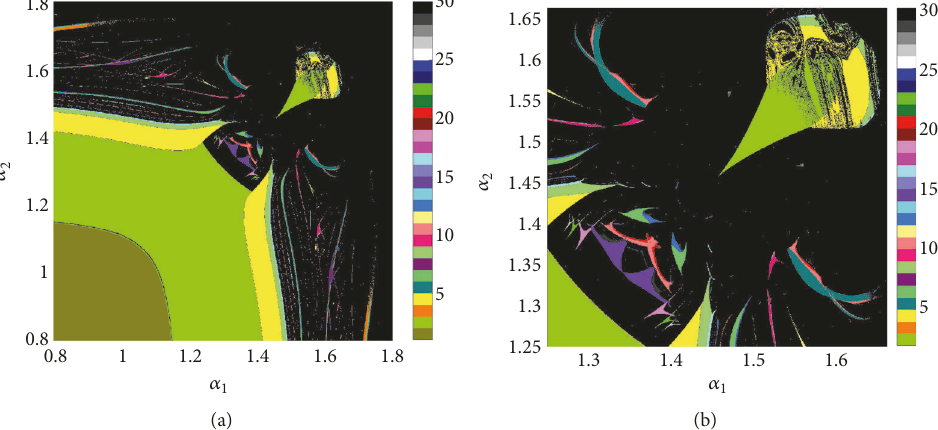
Figure 13: (a) The two-parameter bifurcation diagram in the parameter plane (𝛼 1 , 𝛼 2 ) with fixed parameters as 𝑎 = 1.95 , 𝑏 = 0.044 , 𝑐 = 1.58 , 𝛽 = 0.9 , and 𝛾 = 0.77 . (b) Partial enlargement of